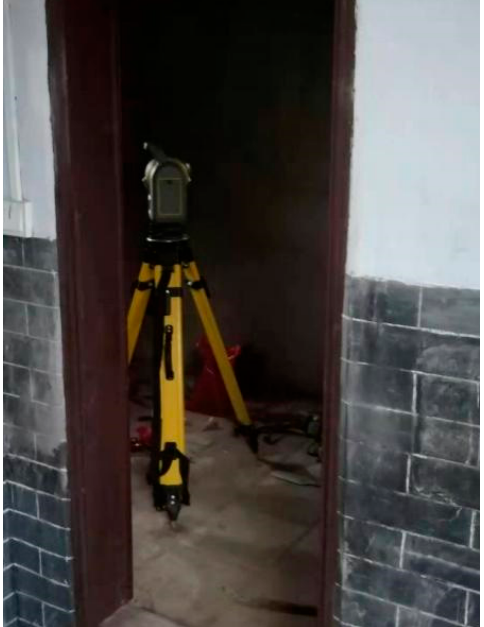
Figure 2. Scanning being performed inside a dark room of a historical building.